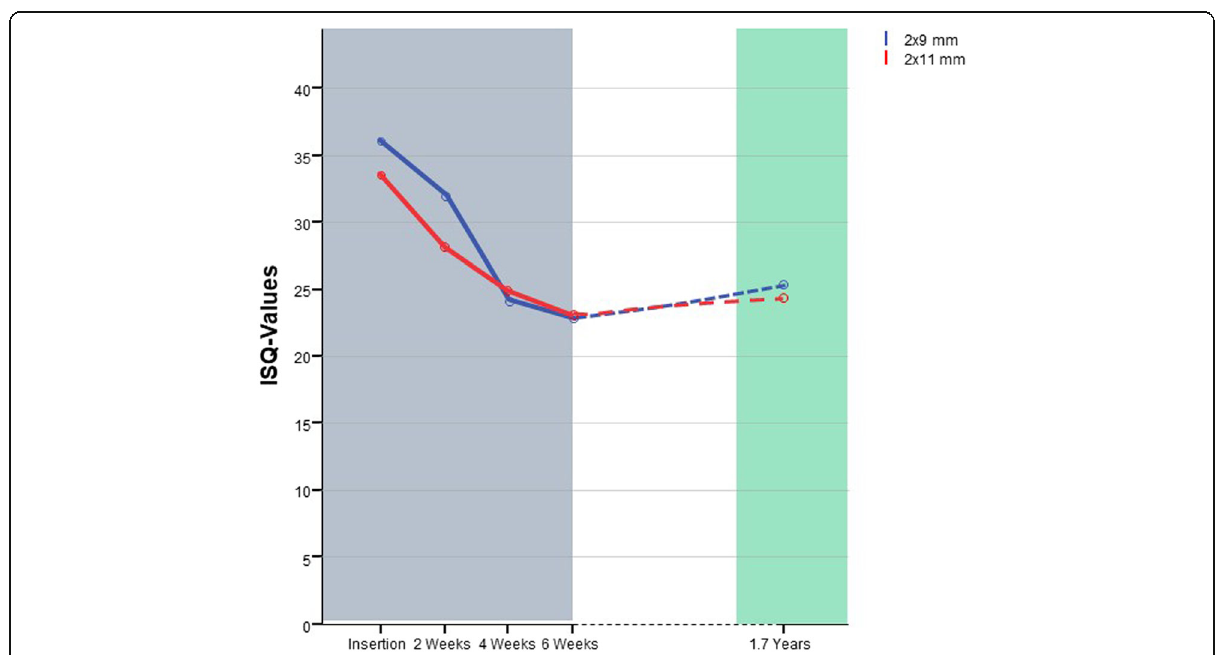
Fig. 3 Development of stability for 2 × 9 and 2 × 11 mm implants